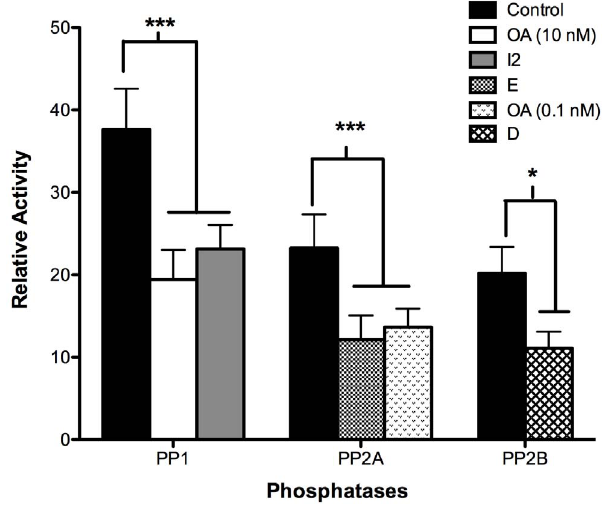
Figure 4. Effect of phosphatase inhibitors on PP1, PP2A, and PP2B enzymatic activity. Sperm were selected and re-suspended in NCM. Each phosphatase activity was measured in sperm extracts as indicated in Materials and Methods in the absence of inhibitors (black bars) and then in the presence of 10 nM okadaic acid (white bar); 40 m g/ml I2 (grey bar); 90 nM endothall (dotted bar); 0.1 nM okadaic acid (light grey bar); or 0.1 nM deltamethrin (striped bar). Results were obtained from five different donors and are expressed as the mean 6 SEM of forty measurements every 2 min. * p , 0.05; ** p , 0.005; *** p , 0.001. The enzymatic activity is expressed as relative activity.